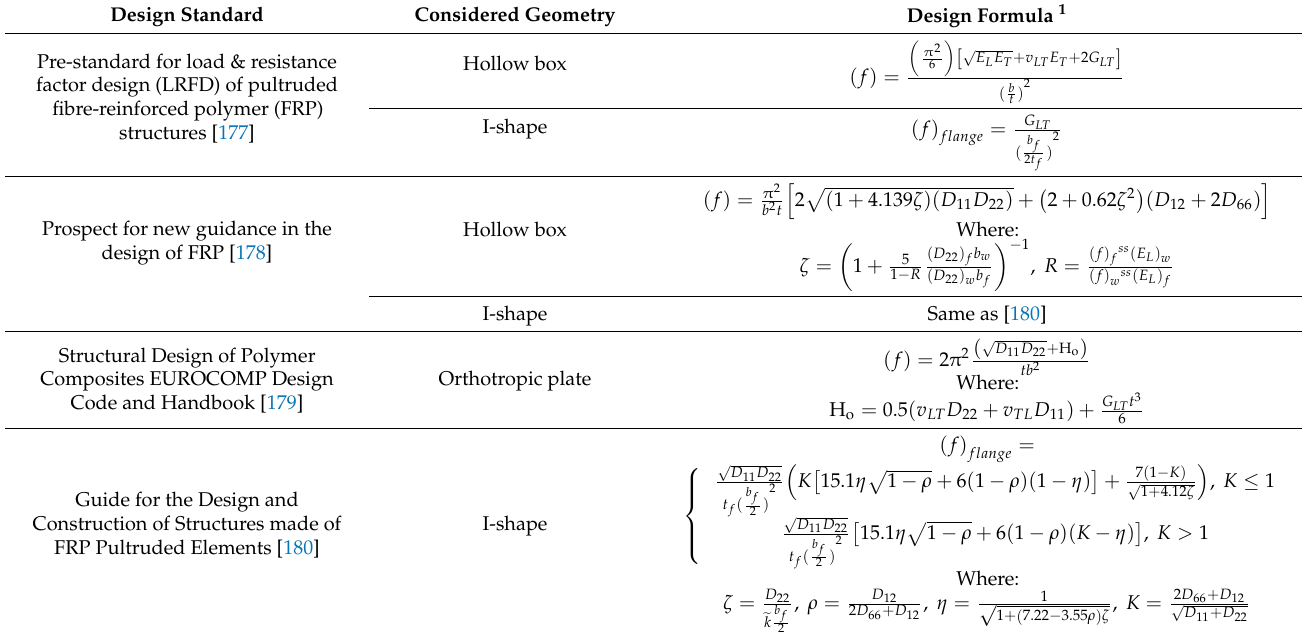
Table 1. Local buckling design formulas of compression box and I-shape members in current standards and guides. Design